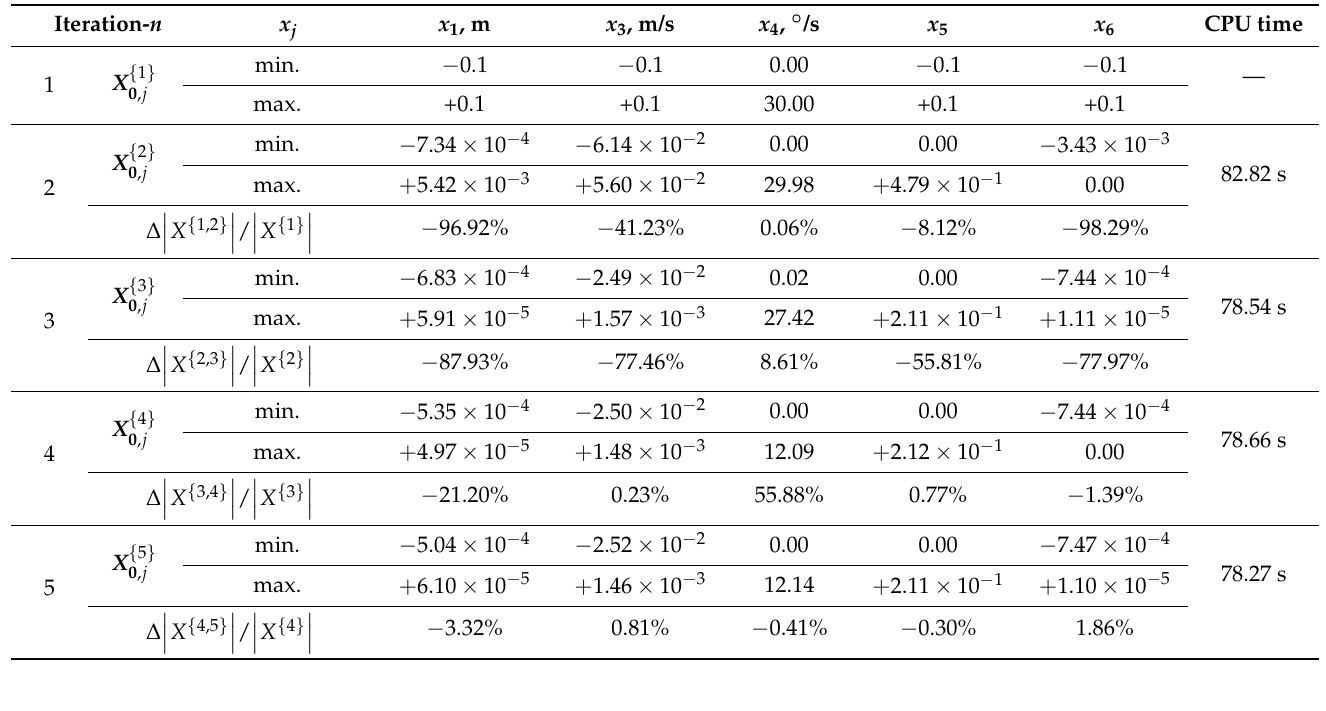
Table 1. Ranges of states, relative changes in ranges, and the central processing unit (CPU) time consumed in each iteration. The airspeed is 20 m/s. An iteration will terminate if all ranges vary within 5% compared to those in the last iteration.